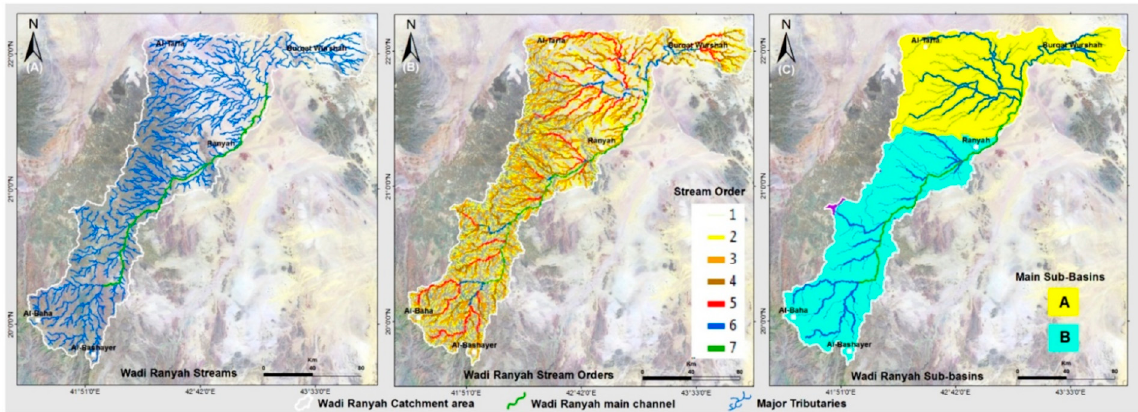
Figure 4. Wadi Ranyah streams ( A ), stream order ( B ), and sub-basins ( C ).